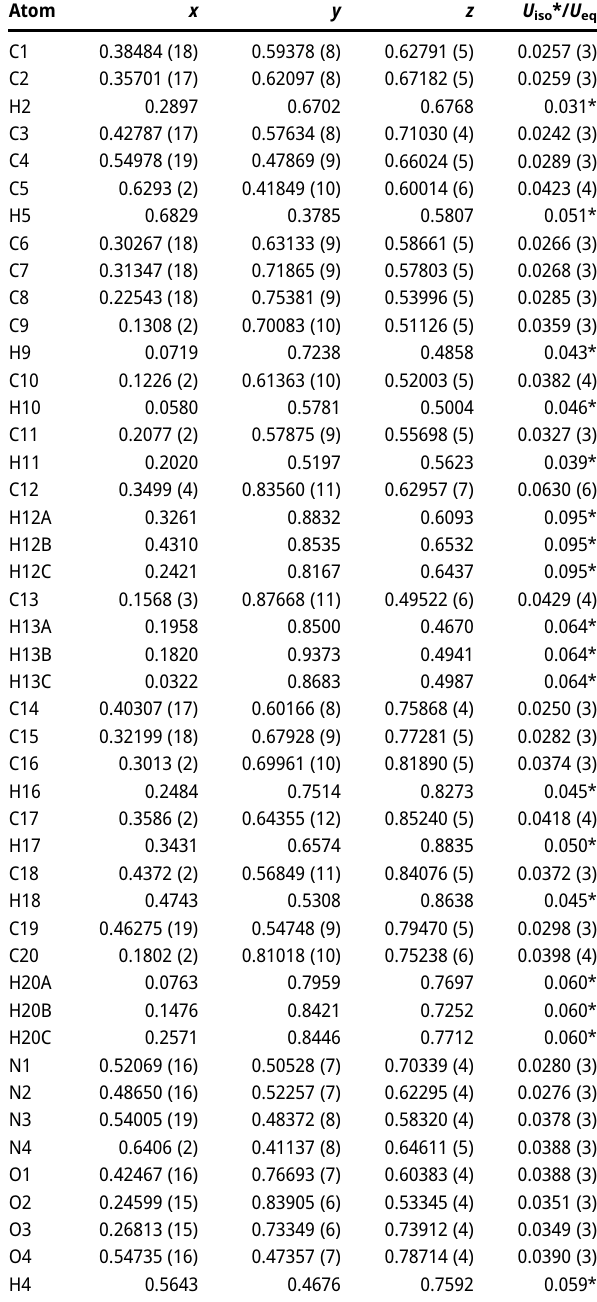
Table  : Fractional atomic coordinates and isotropic or equivalent isotropic displacement parameters (Å 